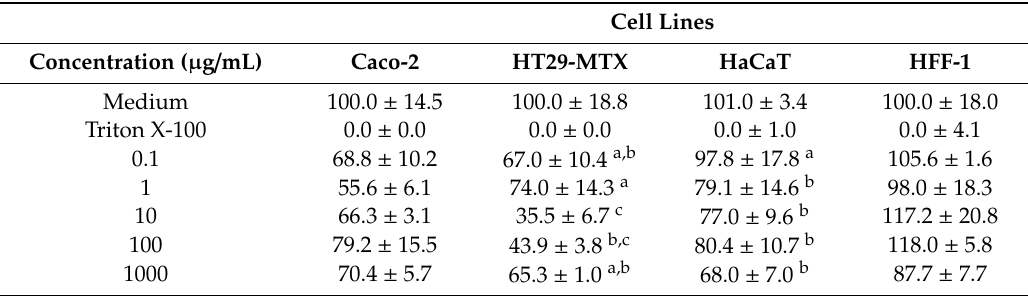
Table 6. E ff ects of optimal extract exposure on the viability of Caco-2, HT29-MTX, HaCaT, and HFF-1 cells at di ff erent concentrations, as measured by the MTT